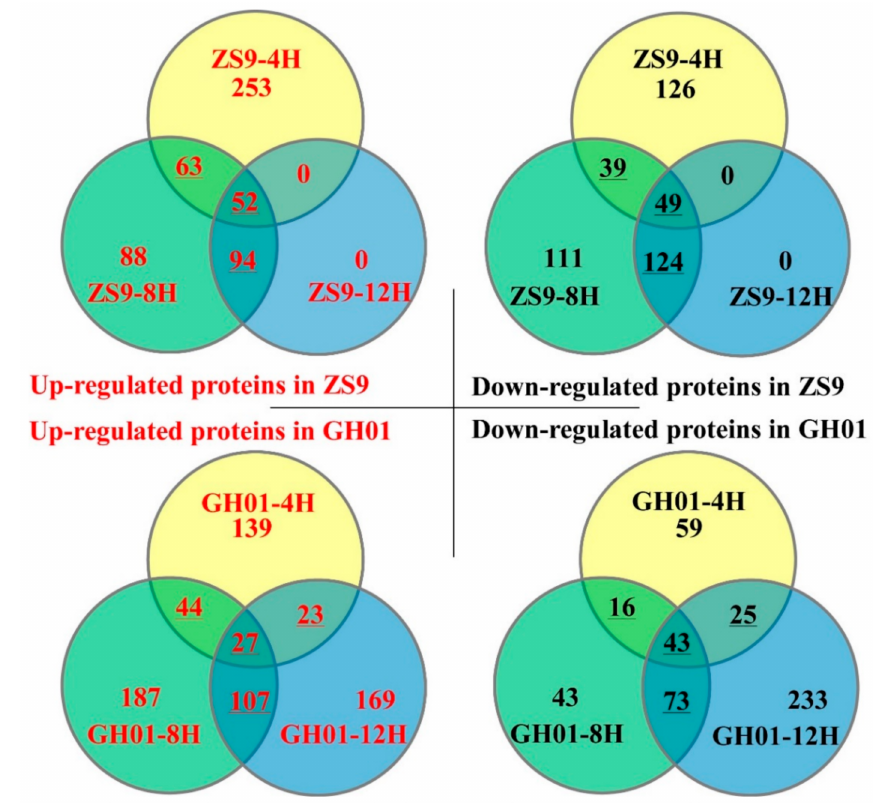
Figure 3. Venn diagram for the number of differentially expressed proteins in ZS9 and GH01 after undergoing waterlogging stress for 4 h, 8 h, and 12 h, the upward-regulated proteins or downward-regulated proteins are in a threshold ratio of >1.20 or